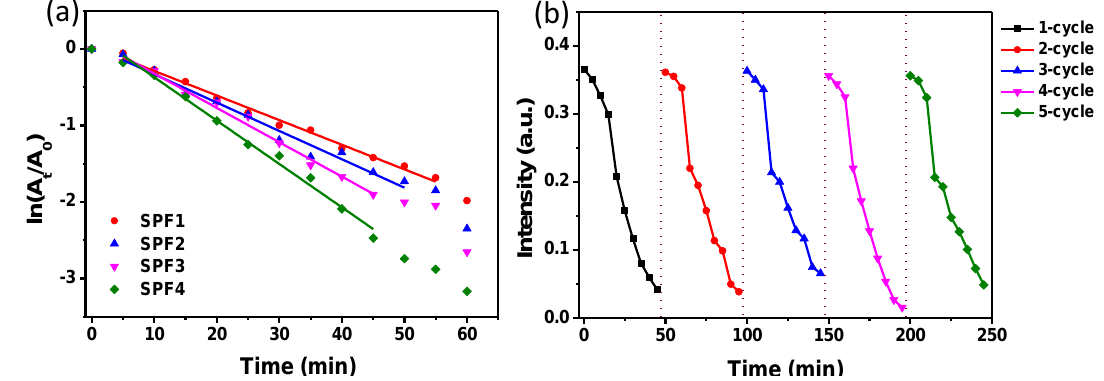
Figure 9. ( a ) Plots of n(A t /A 0 ) at 400 nm as a function of reaction time in the presence of different silk fabrics. ( b ) Recycling and reuse of the PtNP treated silk fabric (PSF3) for the reduction of 4-NP to 4-AP.